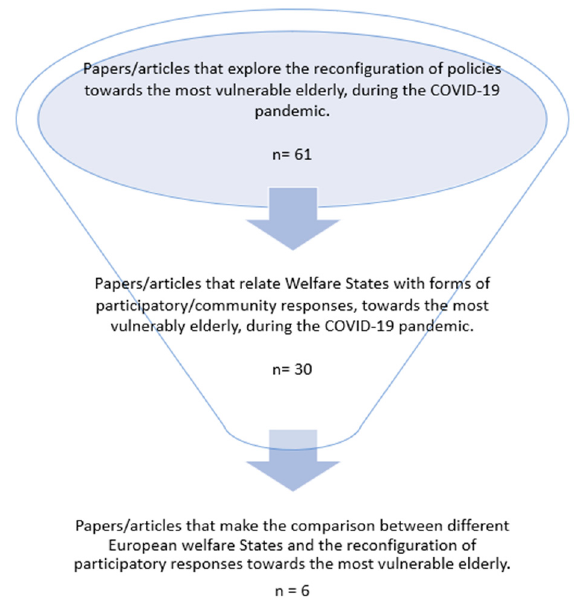
Figure 3. Number of publications obtained, according to the indicators traced in the literature systematization process.